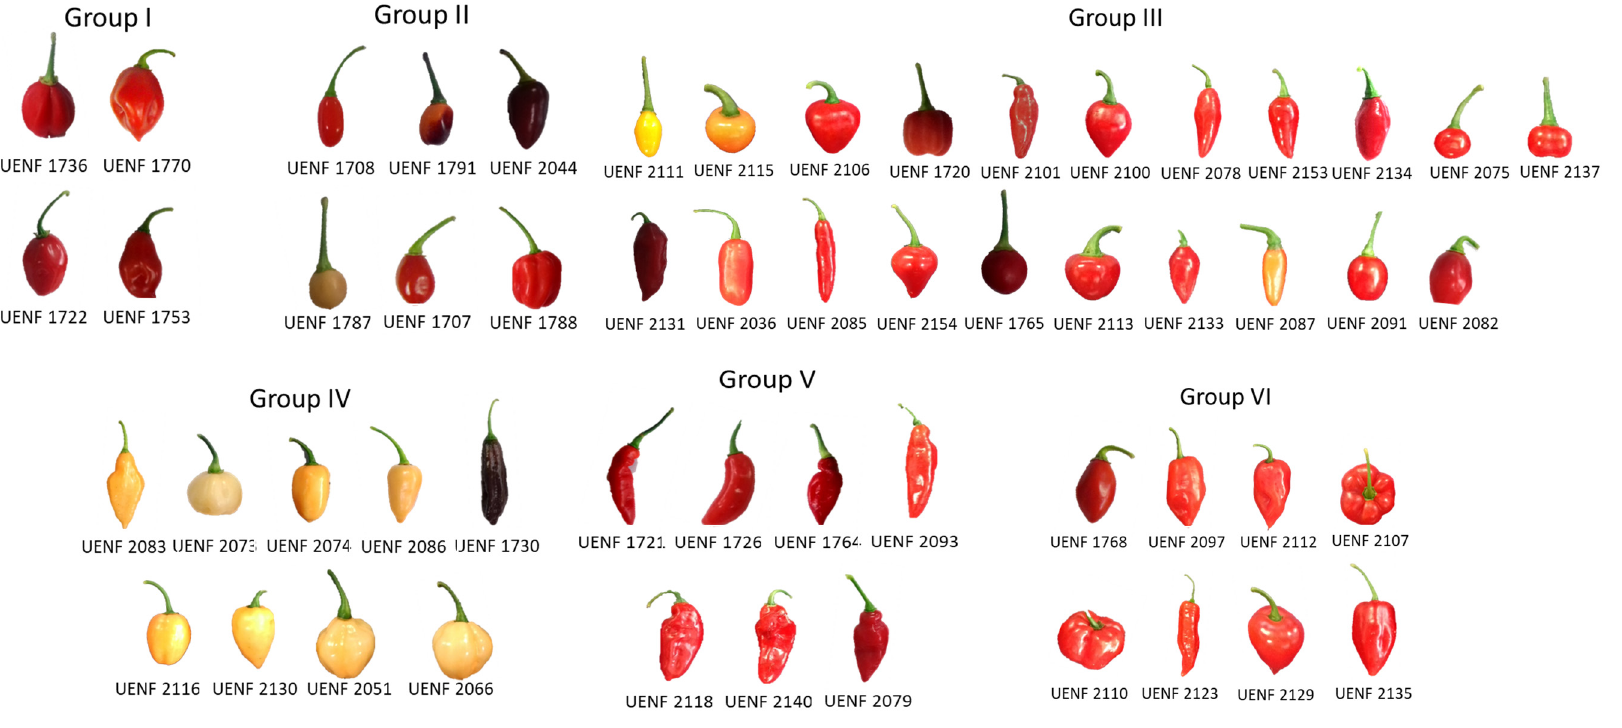
Figure 2. Phenotypic representation of fruits allocated in the dendrogram groups referring to the morpho-agronomic characterization